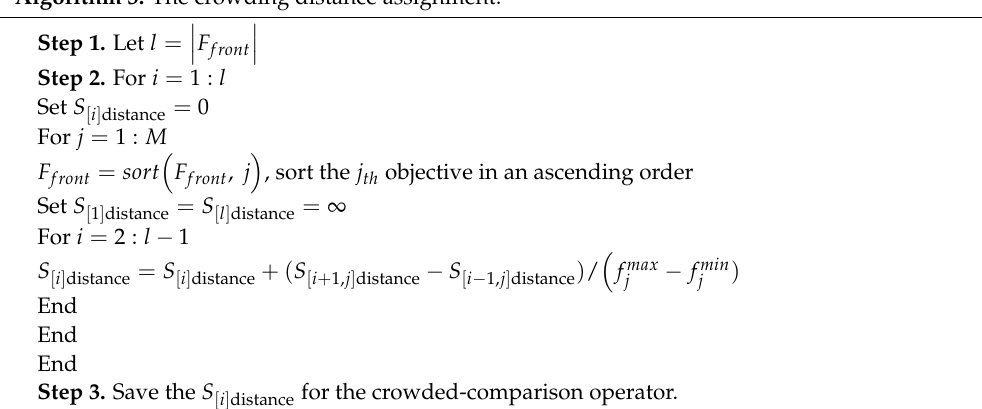
Algorithm 3. The crowding distance assignment.